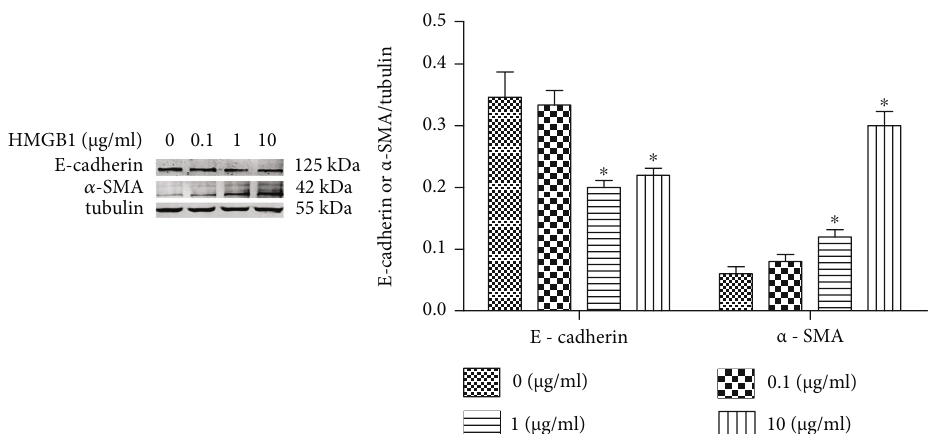
Figure 5: EMT of HK-2 cells is induced by HMGB1 .The HK-2 cells were challenged with HMGB1 at various concentrations (0, 0.1, 1, and 10 μ g/mL) for 24h. Representative Western blotting analysis image of α -SMA and E-cadherin expressions in di ff erent groups. ∗ P < 0 : 05 compared with the control group.